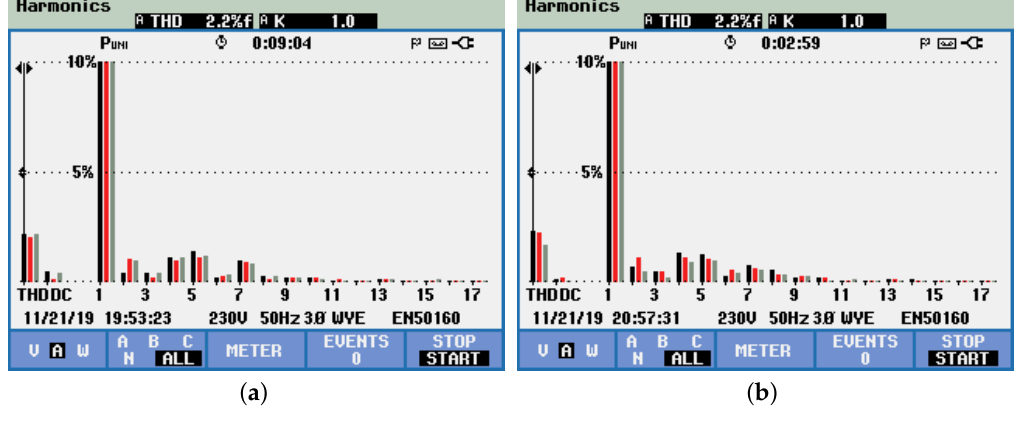
Figure 10. Harmonic spectrum of inductor currents of both controllers. ( a ) PI-based DPC; ( b ) ISMC-based